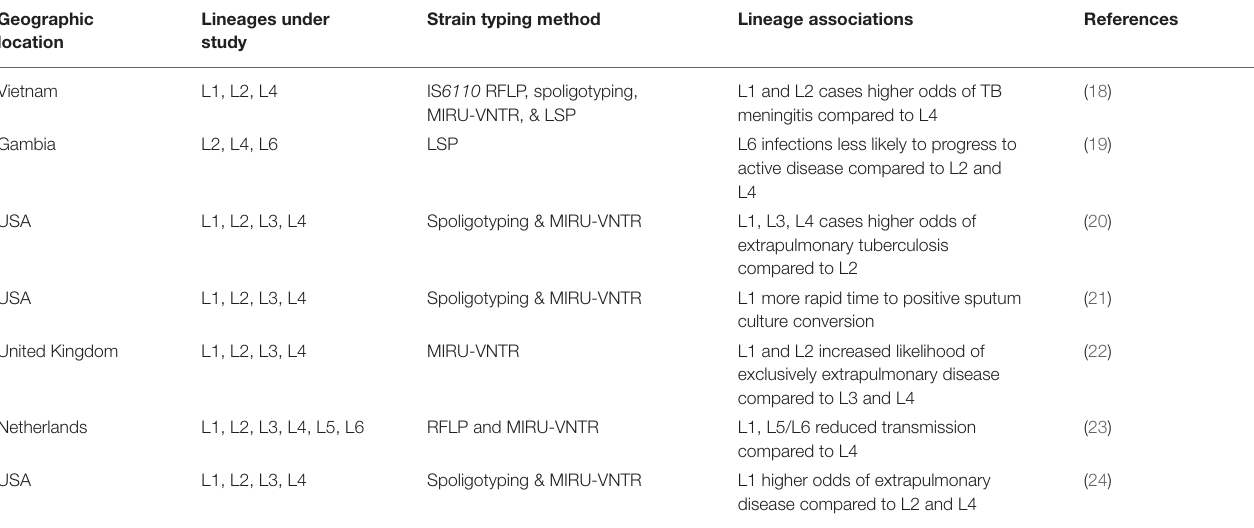
TABLE 1 | Studies investigating multiple Mtb lineages and their associations with disease